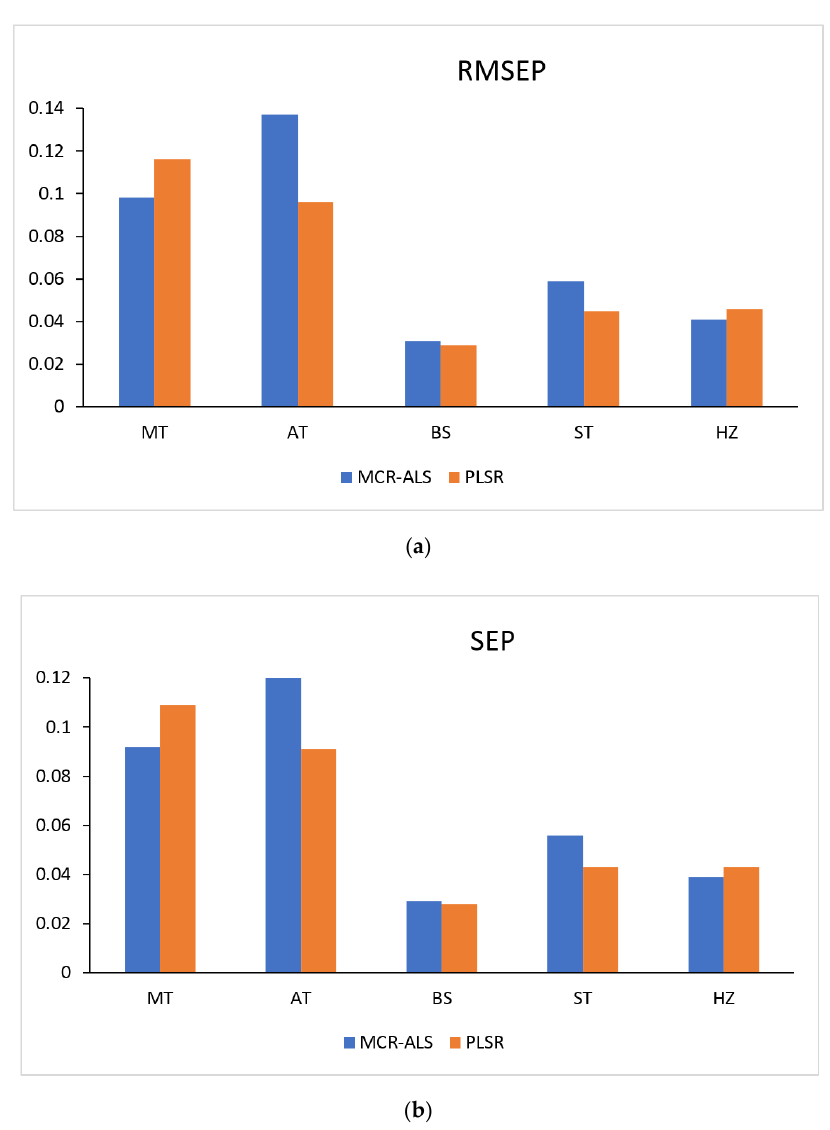
Figure 4. Bar charts for comparison of ( a ) RMSEP and ( b ) SEP values for the investigated drugs determined by applying the MCR-ALS and PLSR proposed methods.